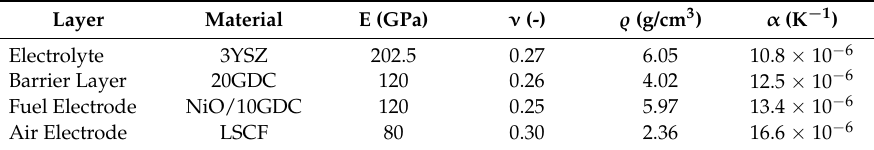
Table 3. List of the cell layers with their composition and nominal thickness.